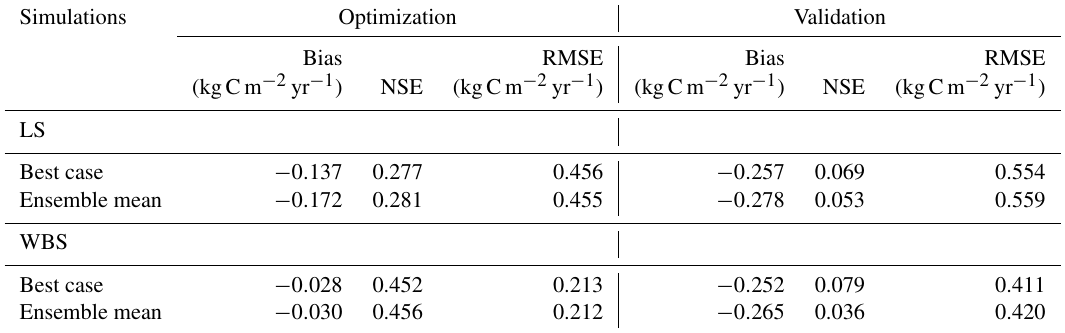
Table 7. Bias, NSE, and RMSE for optimization and validation of GPP for the best case and the top 10 ensemble means for both EC stations.